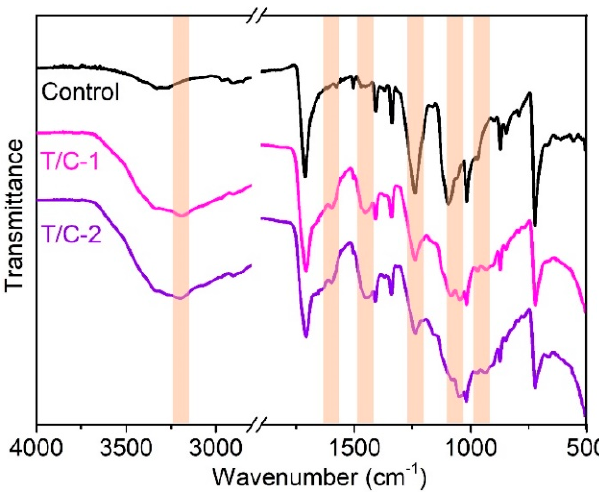
Figure 2. ATR ‐ FTIR spectra of the coated T/C blend fabrics. Figure 2. ATR-FTIR spectra of the coated T/C blend